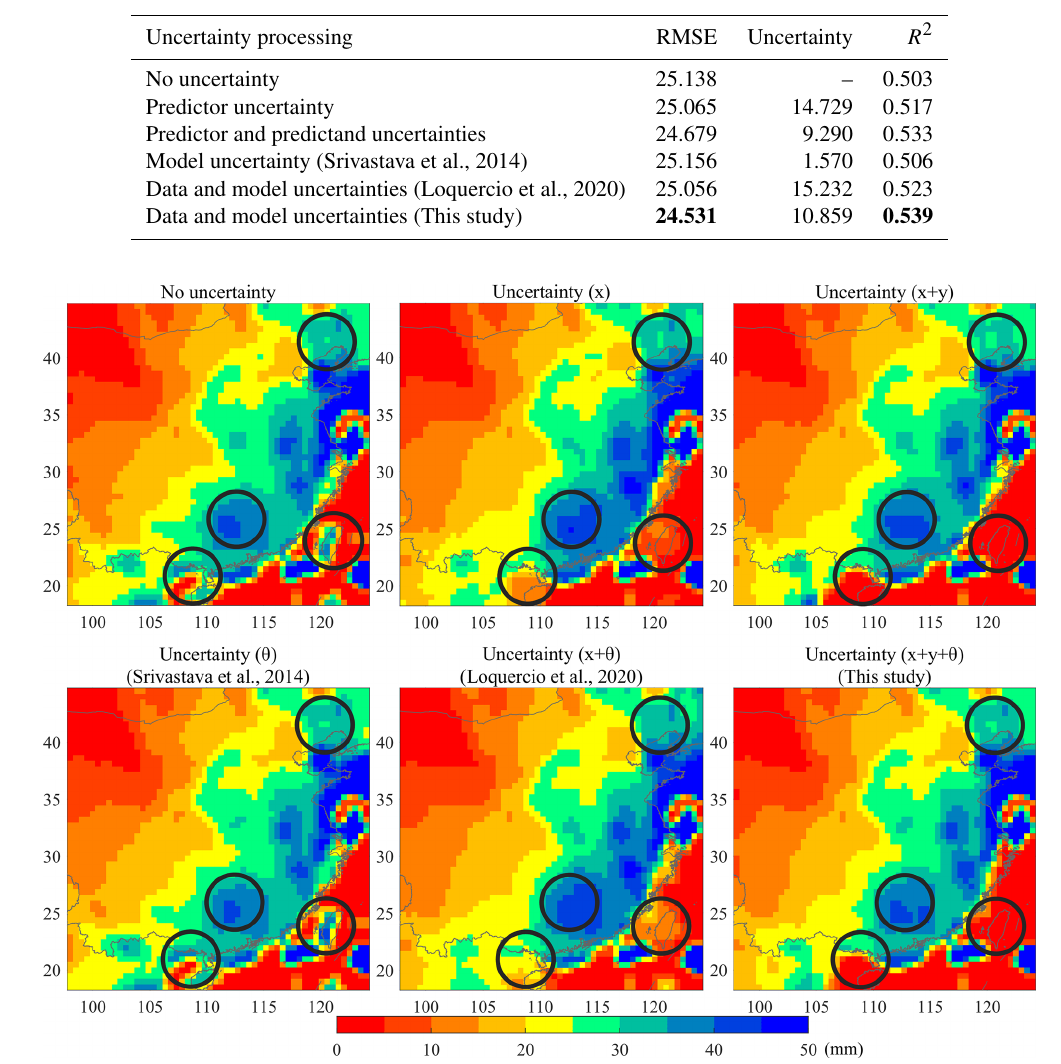
Figure 6. The spatial patterns of RMSE for precipitation forecasting. In this figure, x means the modeling of input uncertainty; x + y represents the modeling of input and output uncertainty; x + y + θ indicates the modeling of input uncertainty, output uncertainty and model uncertainty. The black circles represent the highlighted